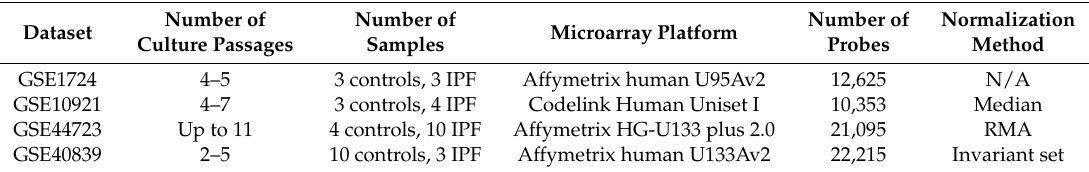
Table 1. Technical characteristics of the source studies. N/A: not available. RMA: Robust Multi-array